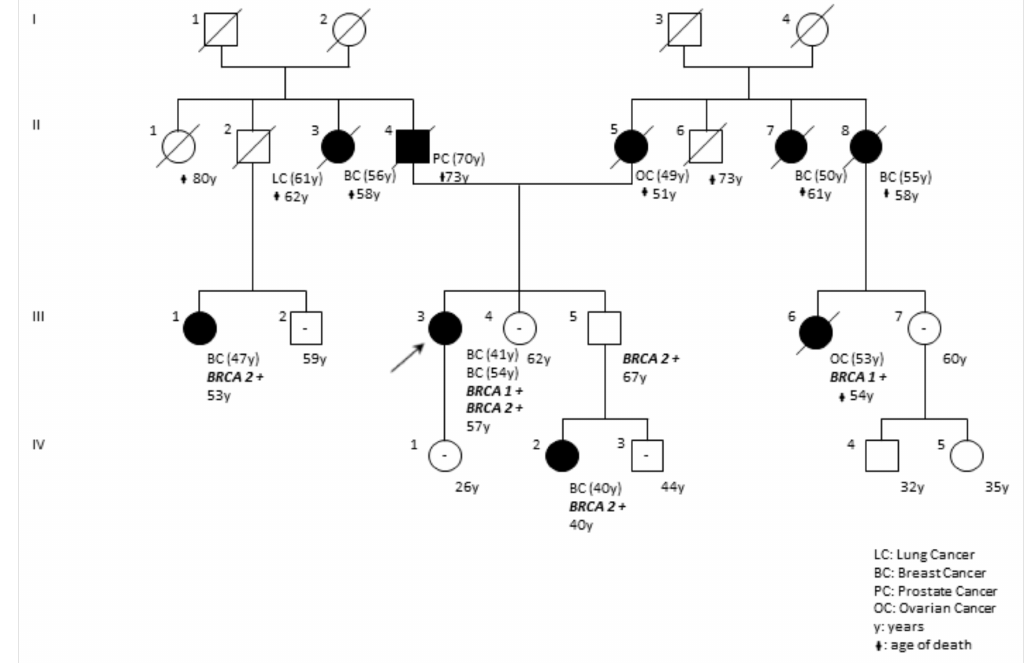
Figure 7. Pedigree of the family with double heterozygosity for BRCA1 c.5095C>T; p.(Arg1699Trp) and BRCA2 c.1238delT; p.(Leu413His fs Ter17) variants. Proband is indicated with the arrow. Black circles and squares indicate affected individuals. Cancer type and age at diagnosis are reported and described as: BC, breast cancer; OC, ovarian cancer; LC, lung cancer; PC, prostate cancer. The current age and age of death are also reported. Family members carrying a pathogenic variant are marked with BRCA1+ or BRCA2+ . Family members negative to genetic testing are indicated with the symbol – within the circles or squares. : proband.